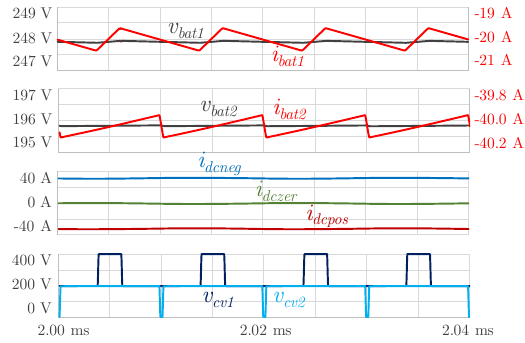
Figure 6. Simulation results of the V2G operation mode when EV1 is discharging with a current of 20 A and EV2 is discharging with a current of 40 A.